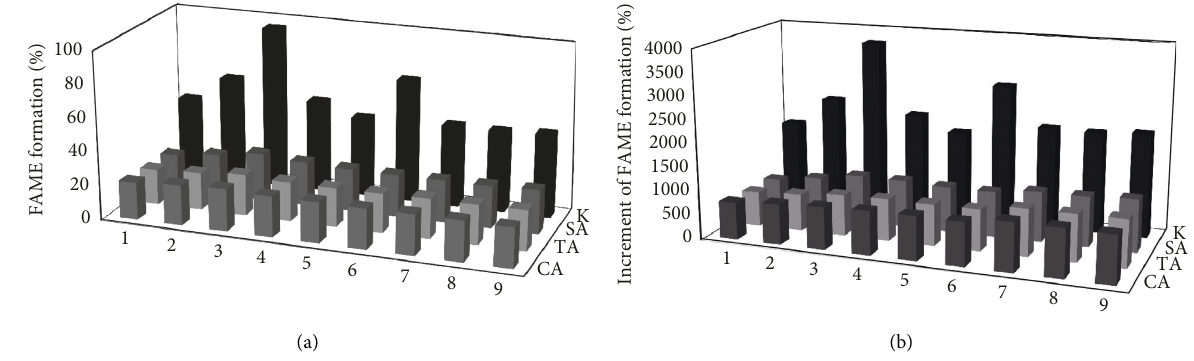
Figure 2: (a) FAME formation of acidic and alkaline heterogeneous catalysts and (b) increment of catalytic properties with respect to the corresponding carbon-based